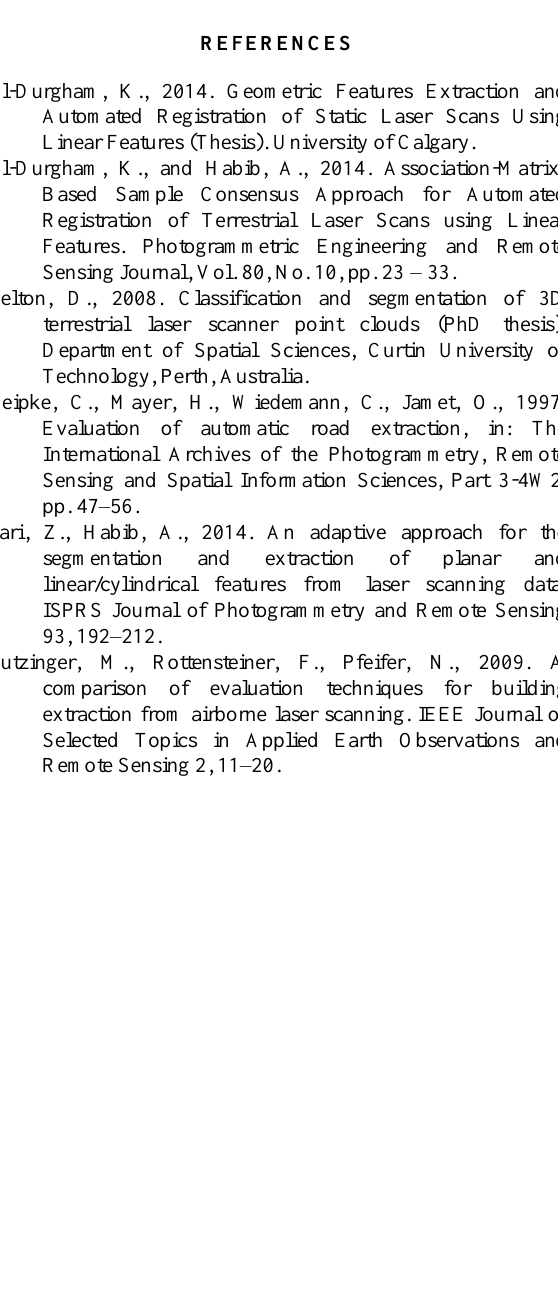
Figure 2. Linear/cylindrical feature segmentation outcome for the static terrestrial laser scanning data (electrical substation): (a) parameter-domain segmentation and (b) spatial-domain segmentation